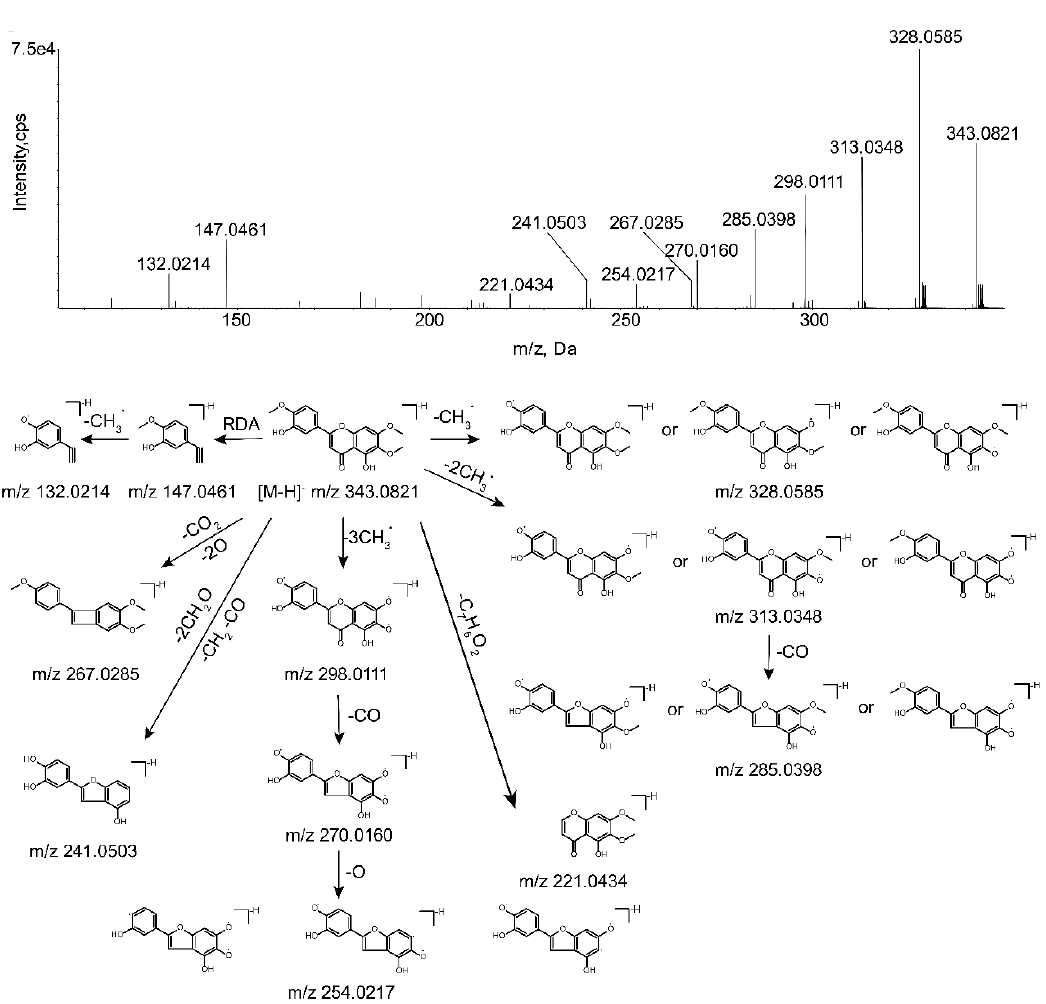
Figure 2. MS / MS spectrum of eupatorin and its predominant fragmentation Figure 2. MS/MS spectrum of eupatorin and its predominant fragmentation pathways.